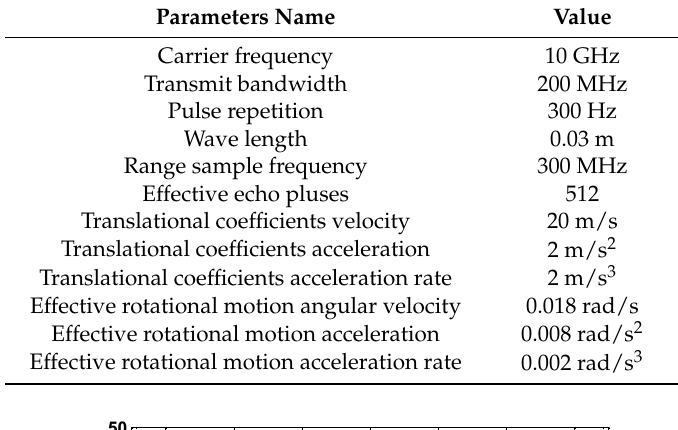
Table 1. Radar parameters and target moving model.